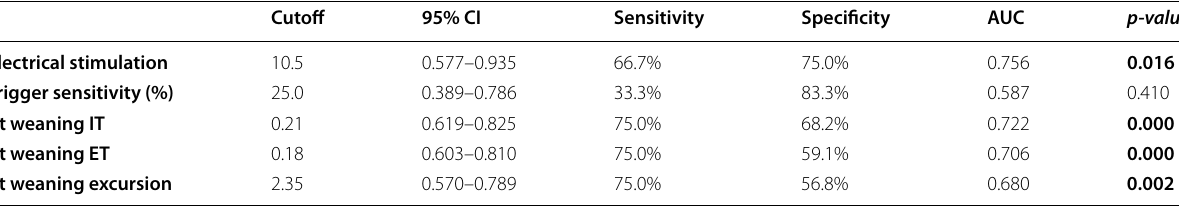
Data are presented in the form of mean SD. * Significance defined by P < 0.05 ± Table 6 The best cutoff, sensitivity, and specificity for simple weaning prediction by different rehabilitation program categories and at weaning diaphragmatic